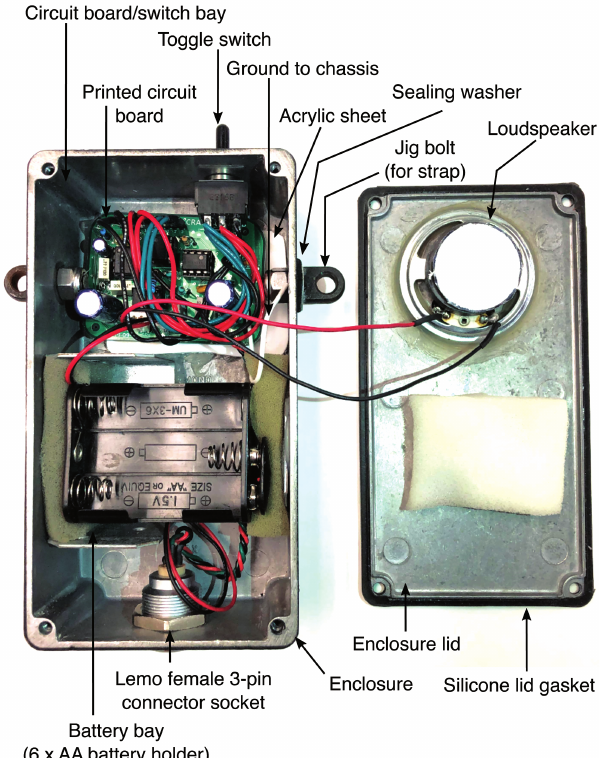
Fig. 3. Internal view of electric fish finder.